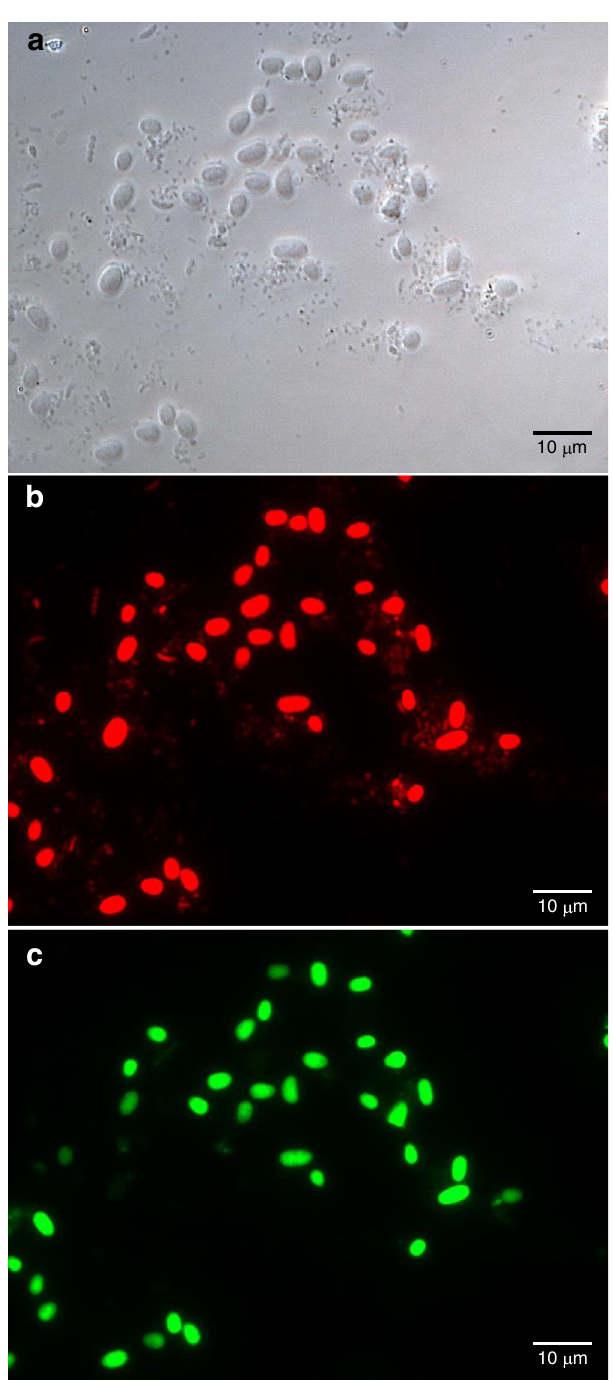
Fig. 3 | Micrographs of concentrated Quinella cells labelled with probes tar- getingrRNA. Thepreparationwasenrichedforlargecellsusingasamplefromthe rumenofasheepwithalargepopulationof Quinella . a Phasecontrastimageofthe enriched preparation. b The same fi eldshowing cellsthathybridised with the Cy3- labelled universal bacterial probe EUB338. c The same fi eld showing cells that hybridised with the Alexa 488-labelled Quinella -speci fi c probe Quin1231. The scale bar indicates a distance of 10 μ m. This image was selected to illustrate the binding of probe Quin1231 to the large oval cells, and similar results were obtained using rumen samples from 6 other